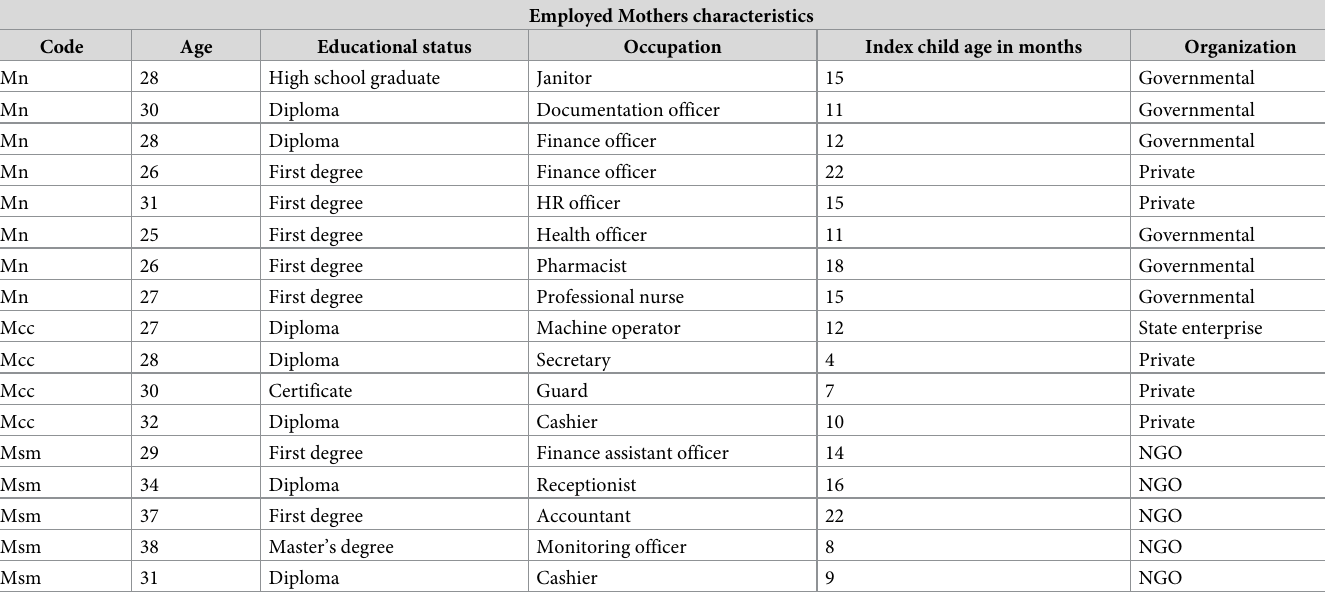
Table 1. Employed mothers’ characteristics in the